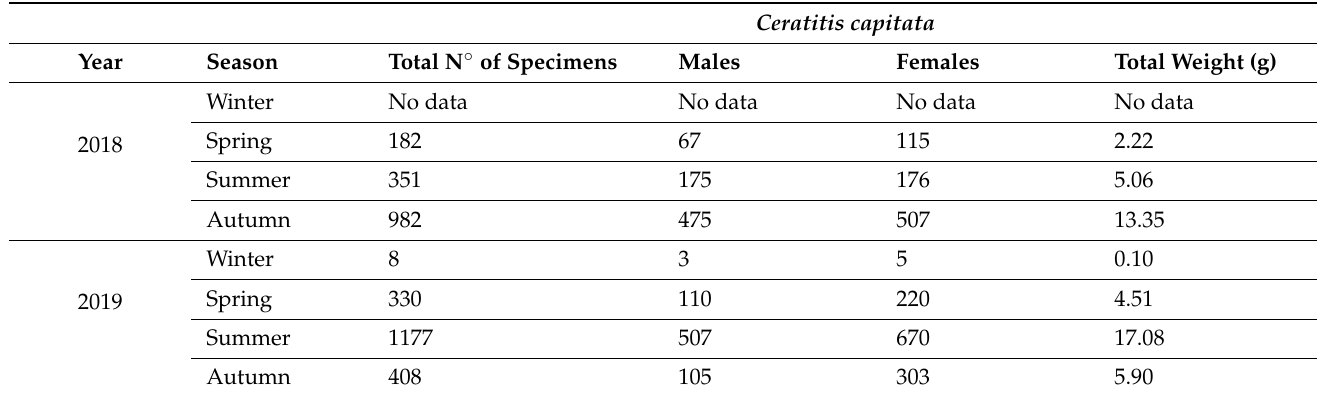
Table 9. Quantification of total biomass and number of specimens of C. capitata captured in all seasons. Ceratitis